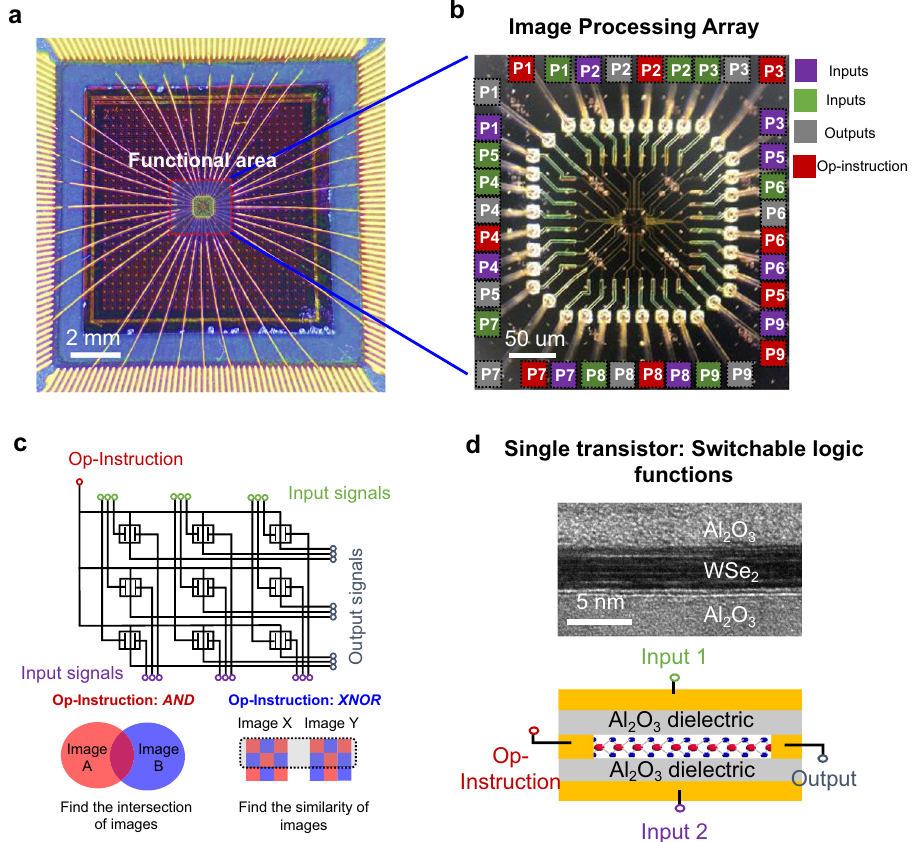
Fig. 1 Image processing array with switchable functions. a Macroscopic image of the bonded device on the carrier, which consists of 3 × 3 pixels, scale bar: 2 mm. b The optical image of the TSC image processing pixel array, scale bar: 50 μ m. We use P1-P9 to mark the ports of each pixel unit. The input 1, input 2, output and Op-instruction ports are coloured by purple, green, grey and red respectively. c Schematic circuit diagram of the pixel processing array. With different Op-Instruction inputs, image intersection and comparing functions are implemented. d Top part: The cross-sectional high-resolution TEM image. The scale bar is 5 nm. Bottom part: Schematic diagram of the single-pixel processing unit. The drain and source of the device serve as the OP- Instruction and output ports, the top gate and bottom gate serve as input 1 and input 2. With the Op-instruction signal input, a single transistor can perform switchable logic